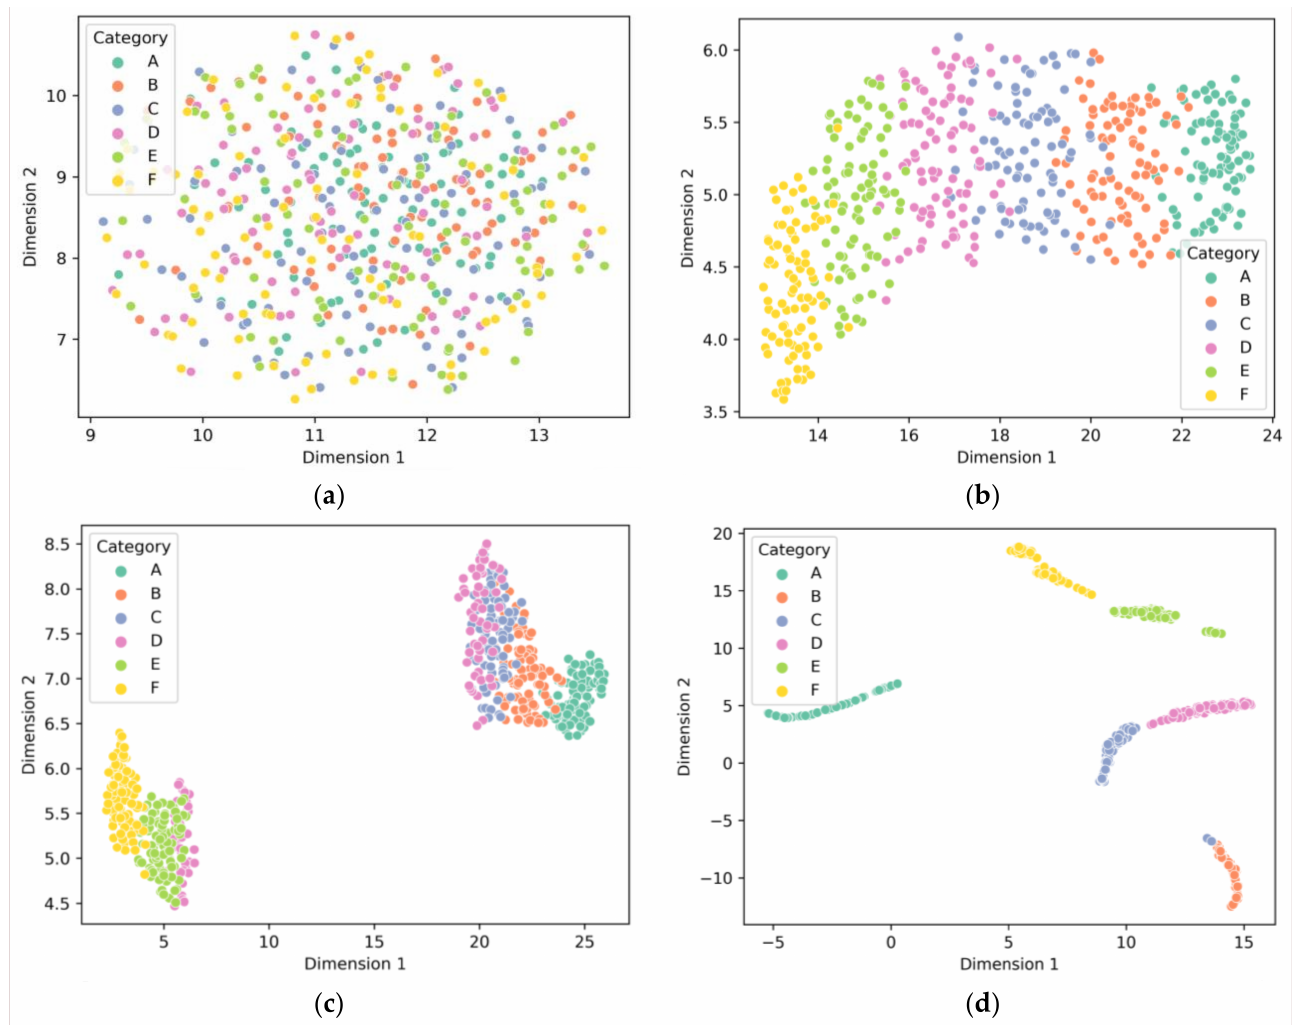
Figure 9. The 1D-RCNN layer output’s UMAP downscaling visualization: ( a ) first convolutional